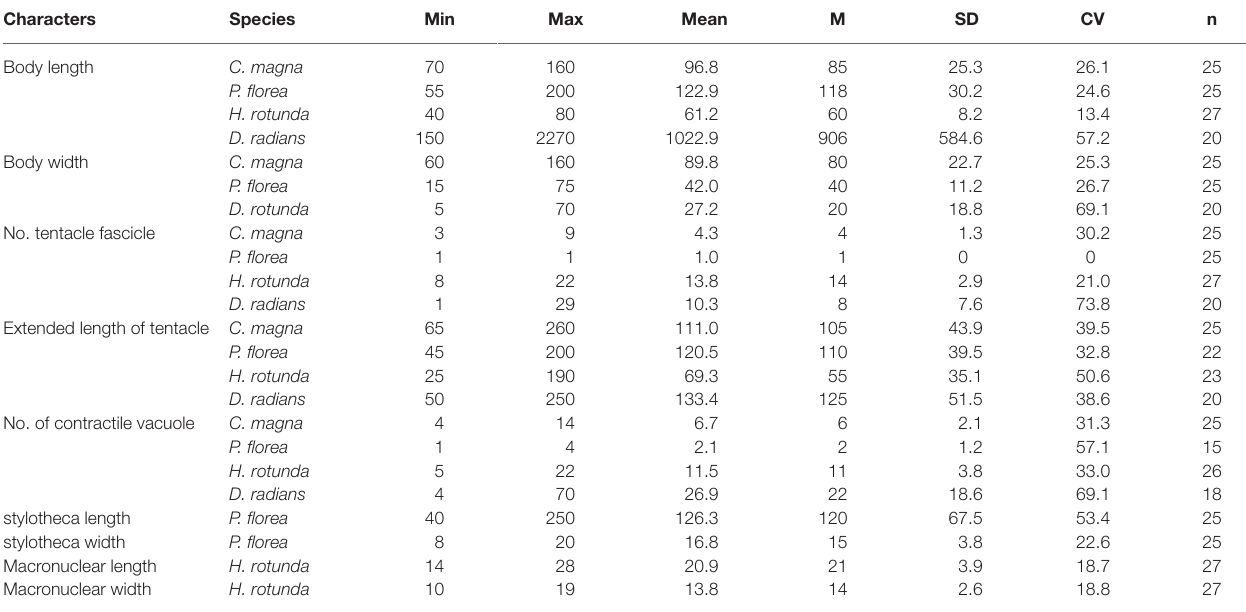
TABLE 1 | Morphological characterization of four